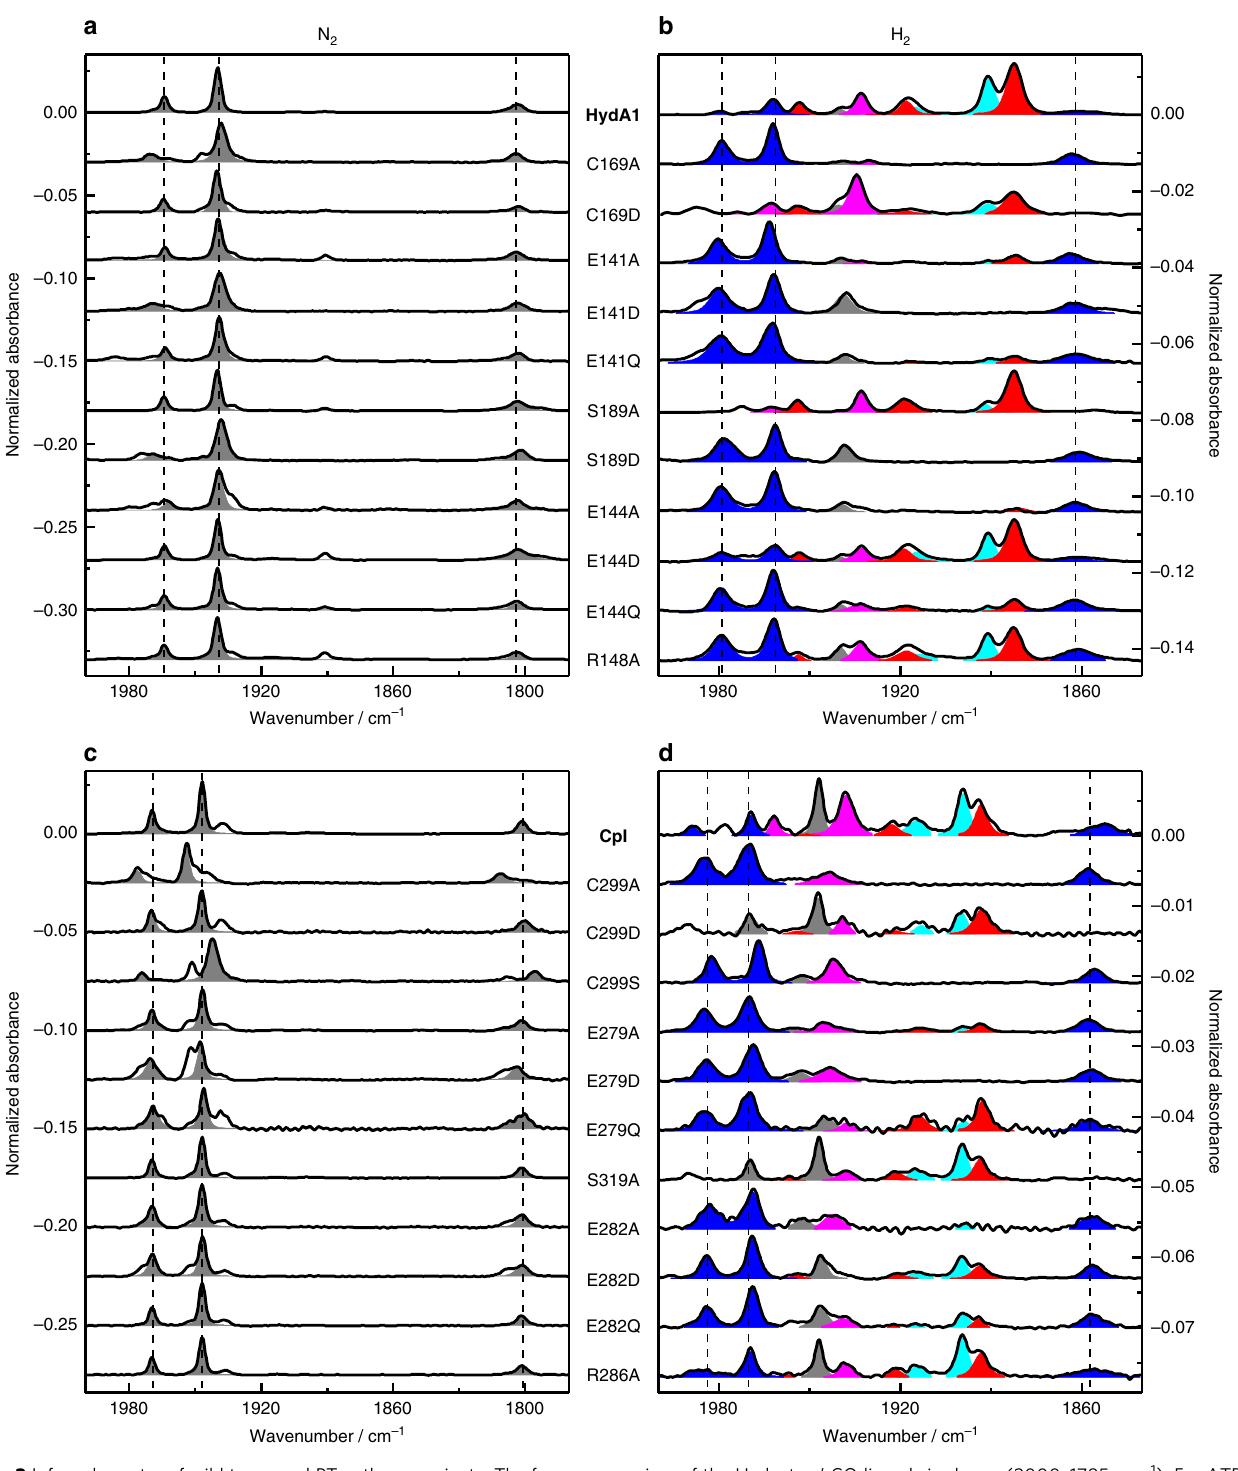
Fig. 3 Infrared spectra of wild types and PT pathway variants. The frequency regime of the H-clusters ’ CO ligands is shown (2000 – 1785 cm − 1 ). For ATR- FTIR spectroscopy, the buffer was set to pH 8 and the rehydrated samples were purged with 100% H 2 for 5 min. a , c Auto-oxidation in absence of H 2 (i.e. purged with N 2 ) was exploited to likewise enrich for all examined proteins the oxidized resting state, H ox (gray bands). Some CpI variants tend to accumulate H ox H in parallel with H ox (e.g. C299A bands at frequencies 1975/1953/1809) 34 . b , d When shifting from N 2 to H 2 the spectrum of wild-type protein changes to different fractions of reduced species including H red (cyan) and H sred (red) as well as H red ´ (magenta). Most PT pathway variants accumulate H hyd (blue) instead or in addition to a mix of reduced states. For precise state-speci fi c vibrational signals of CpI and HydA1 see Supplementary